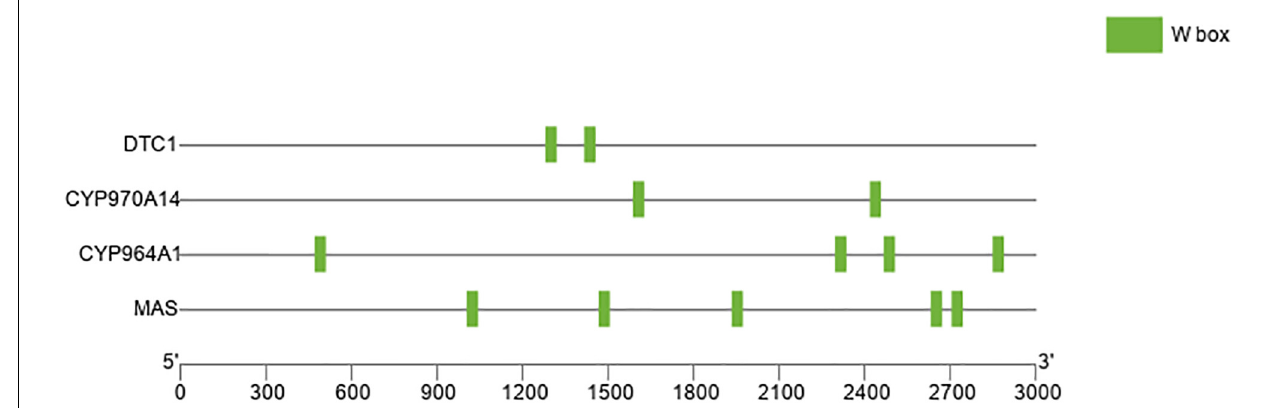
FIGURE 5 | Distribution of WRKY binding sites (W-box: TTGACT/C) in the biosynthetic gene cluster (BGC) in Calohypnum plumiforme genome. A 3,000 bp sequence in the promoter of CpDTC1/HpDTC1 , CpCYP970A14 , CpCYP964A1 , and CpMAS gene was analyzed.